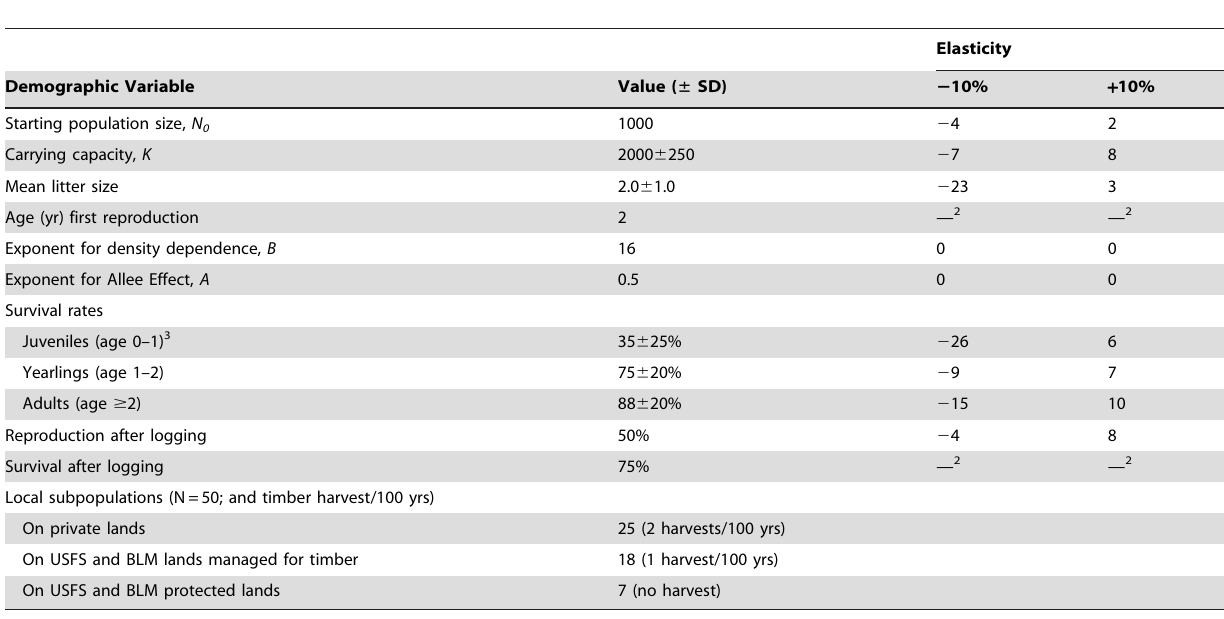
Table 1. Values for demographic parameters and characteristics of the model source fisher population.